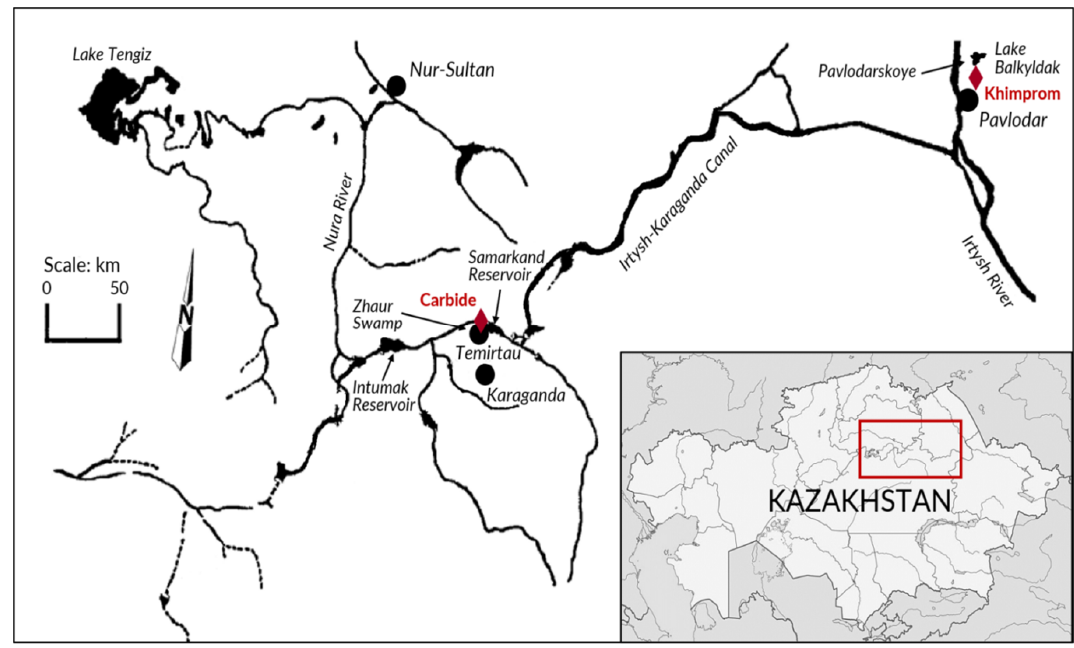
Figure 1. Map showing Hg-contaminated sites in Kazakhstan (adapted from [22]).